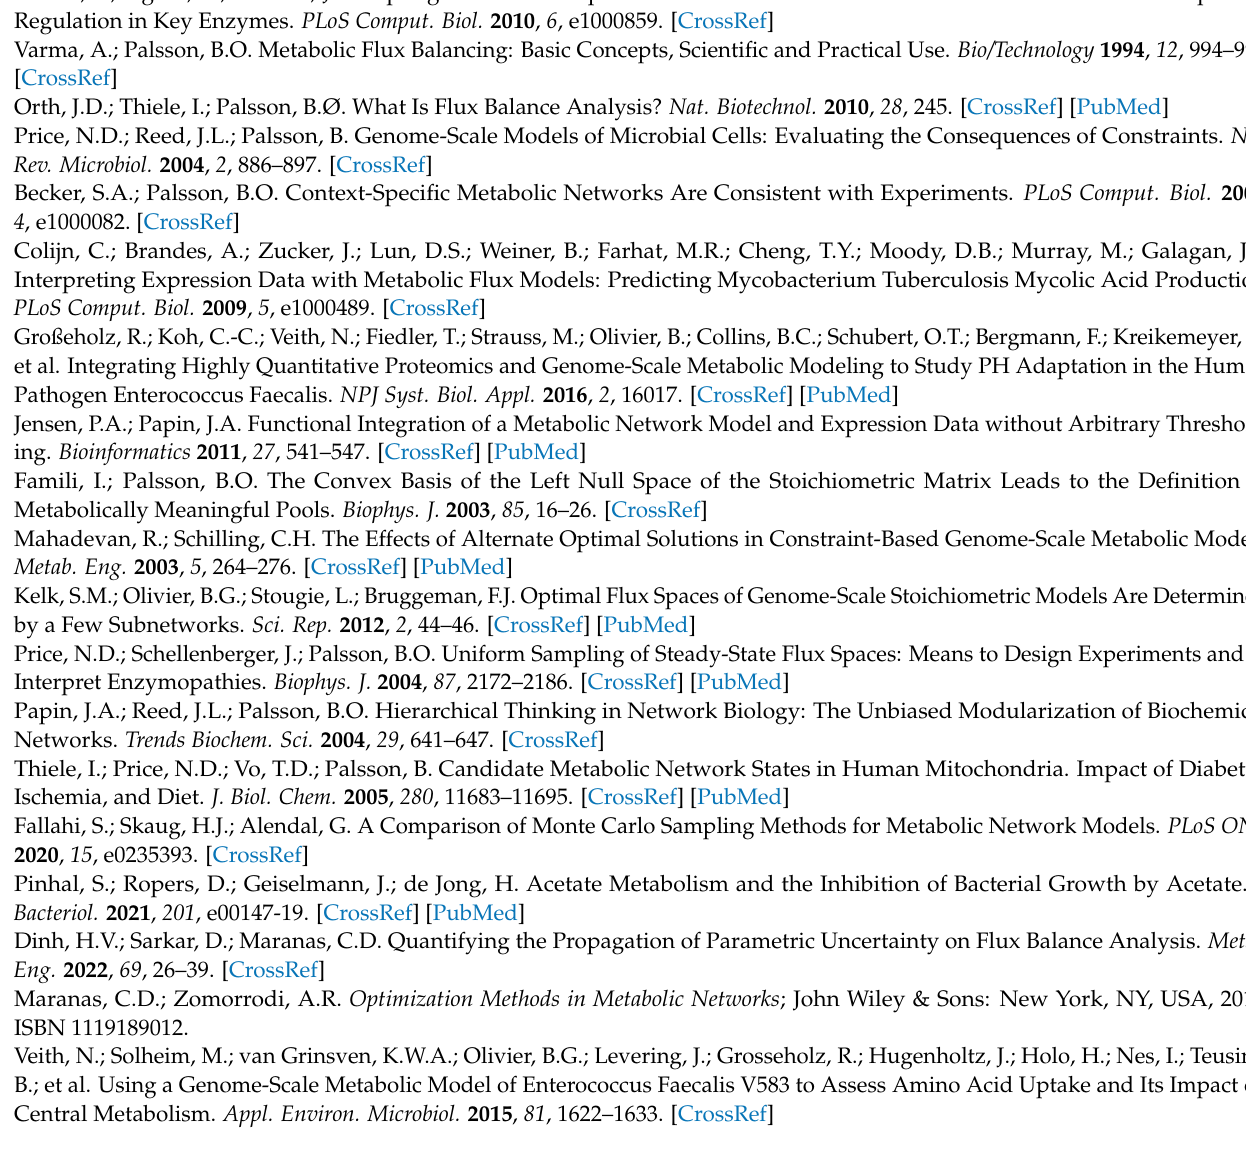
Supplementary file 2, Table S2a: The run time of different models using the perturbation process for FBA and